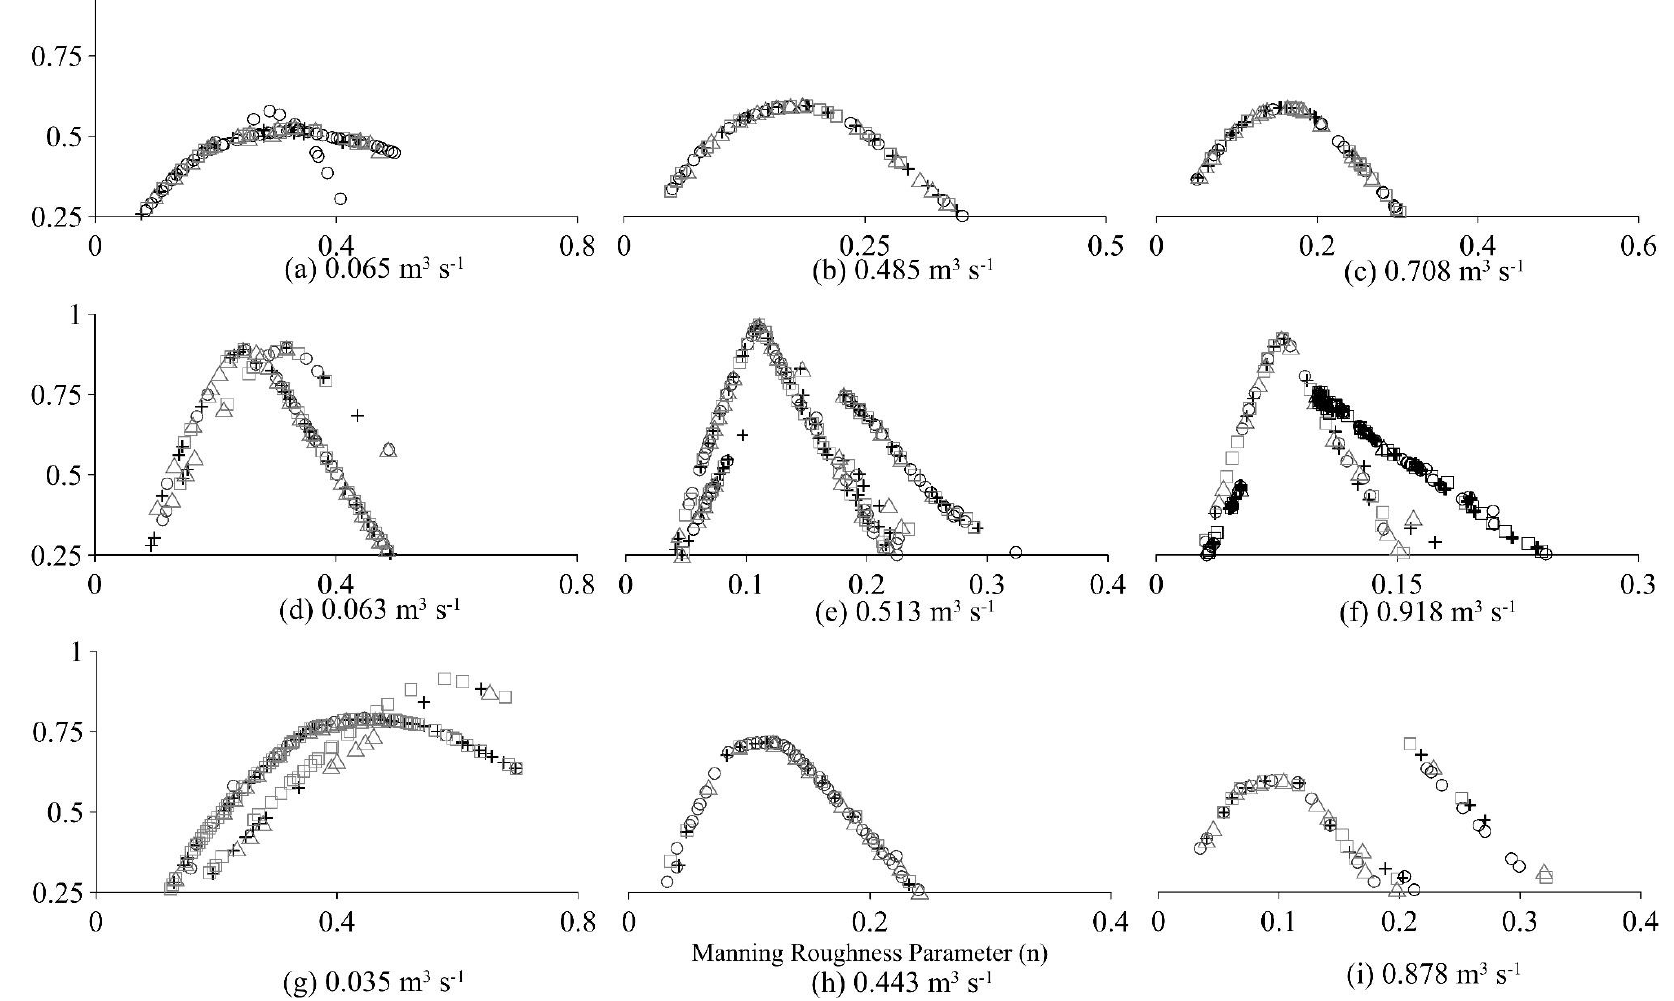
Figure 4. GLUE likelihood curves in Experiment 1: Cascade ( a – c ), Plane-bed ( d – f ), and Step-pool ( g – i ).